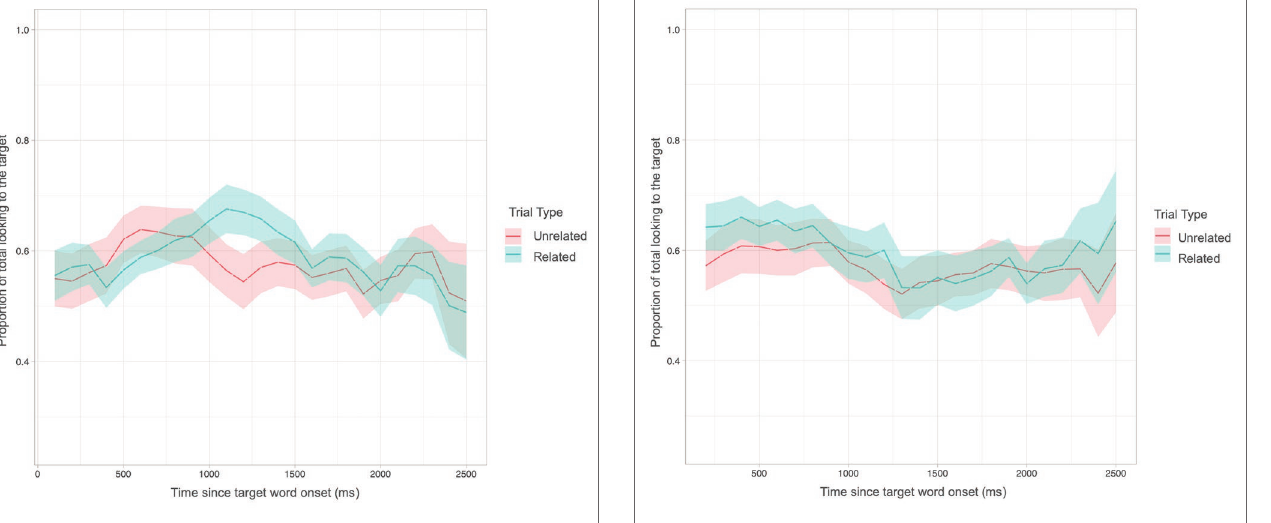
FIGURE 5 | Proportion of looks to the target for related and unrelated trials over time at 18 months.